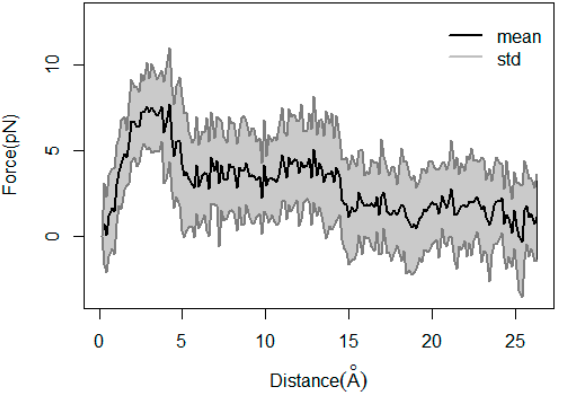
Figure 5. The average force versus the distance of ligand dissociation from the receptor in Route 1.